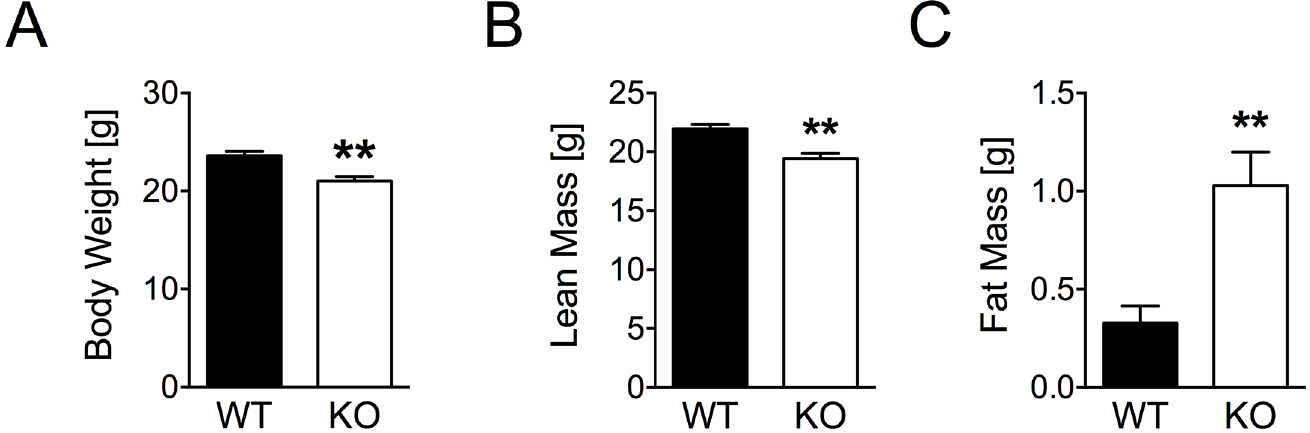
Fig 3. Body weight and body composition in chow-fed DUSP6 WT and KO mice. Age-matched DUSP6 WT and KO mice (Age 7.3 ± 0.3 vs. 7.6 ± 0.1 weeks) were fed standardchow-dietand monitored for their body weight (A), lean mass (B) and fat mass (C). n = 8. Means ± SEM, ** p < 0.01.